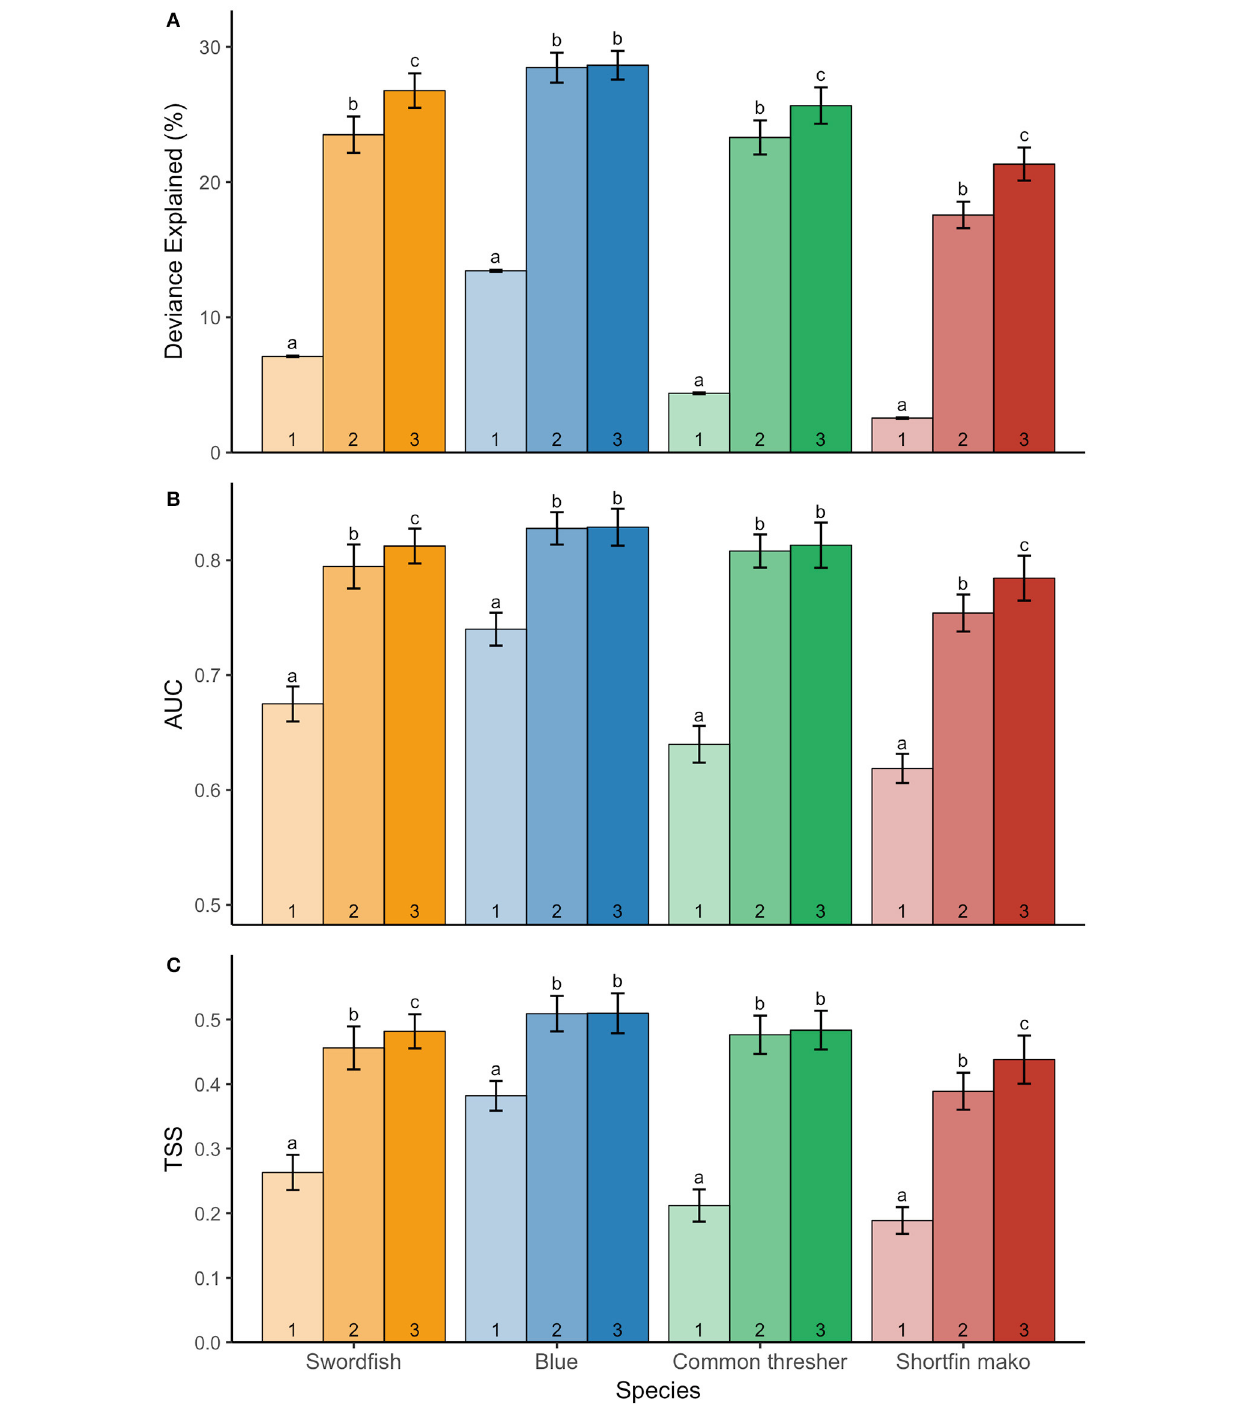
FIGURE 4 | Mean ± S.D. (A) deviance explained; (B) AUC; and (C) TSS for three model simulations indicated numerically: simulation 1 (static variables only); simulation 2 (static and dynamic surface variables); and simulation 3 (static and dynamic surface and subsurface variables). Species’ model simulations were run 50 times to generate mean ± S.D, with significance denoted by letters (ANOVA and Tukey HSD, p < 0.05). Models for each species are shown: swordfish (yellow), blue sharks (blue), common thresher sharks (green), and shortfin mako sharks (red). Letters are only comparable among simulations of the same species.